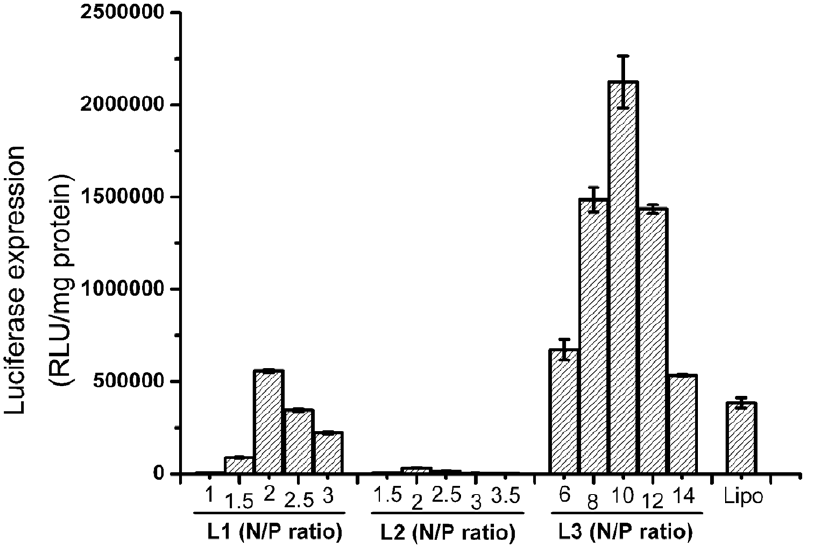
Figure 8. Transfection efficiencies of L1–L3 at various N/P ratios using optimized lipid/DOPE ratio of 1 : 2 in A549 cells. Concentration of the DNA was 2 m g/well and lipofectamine 2000 TM was used as control. Data are expressed as relative light units (RLU)/mg of protein.